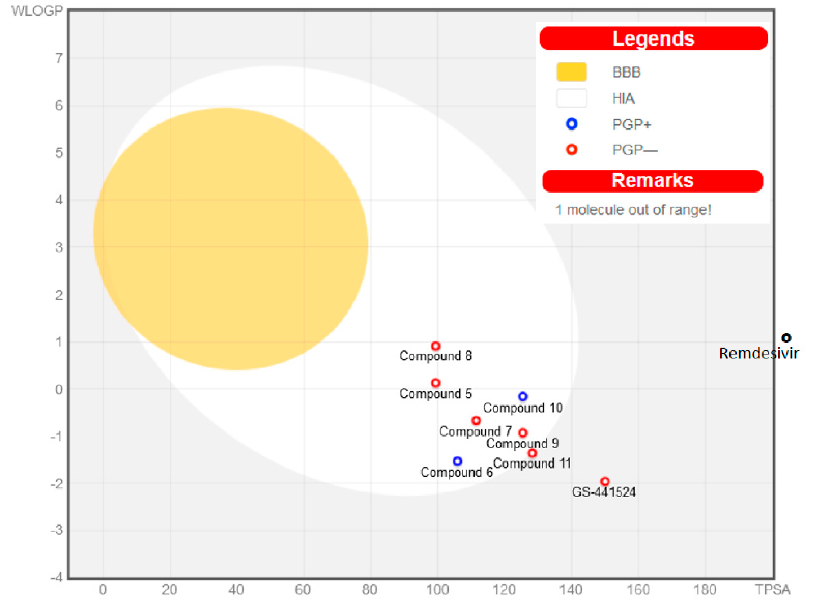
Figure 5. WLOGP-versus-TPSA boiled egg visualization compounds 5 – 11 in comparison with remdesivir and GS-441524.